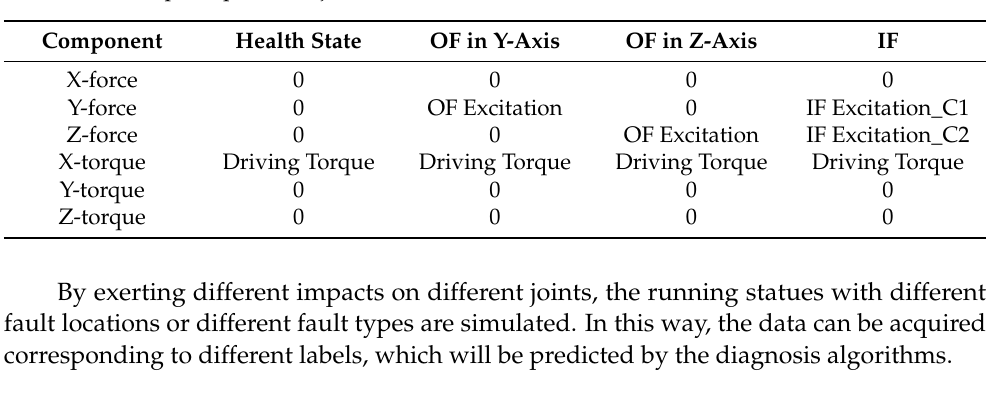
Table 2. The set principle of the joint health